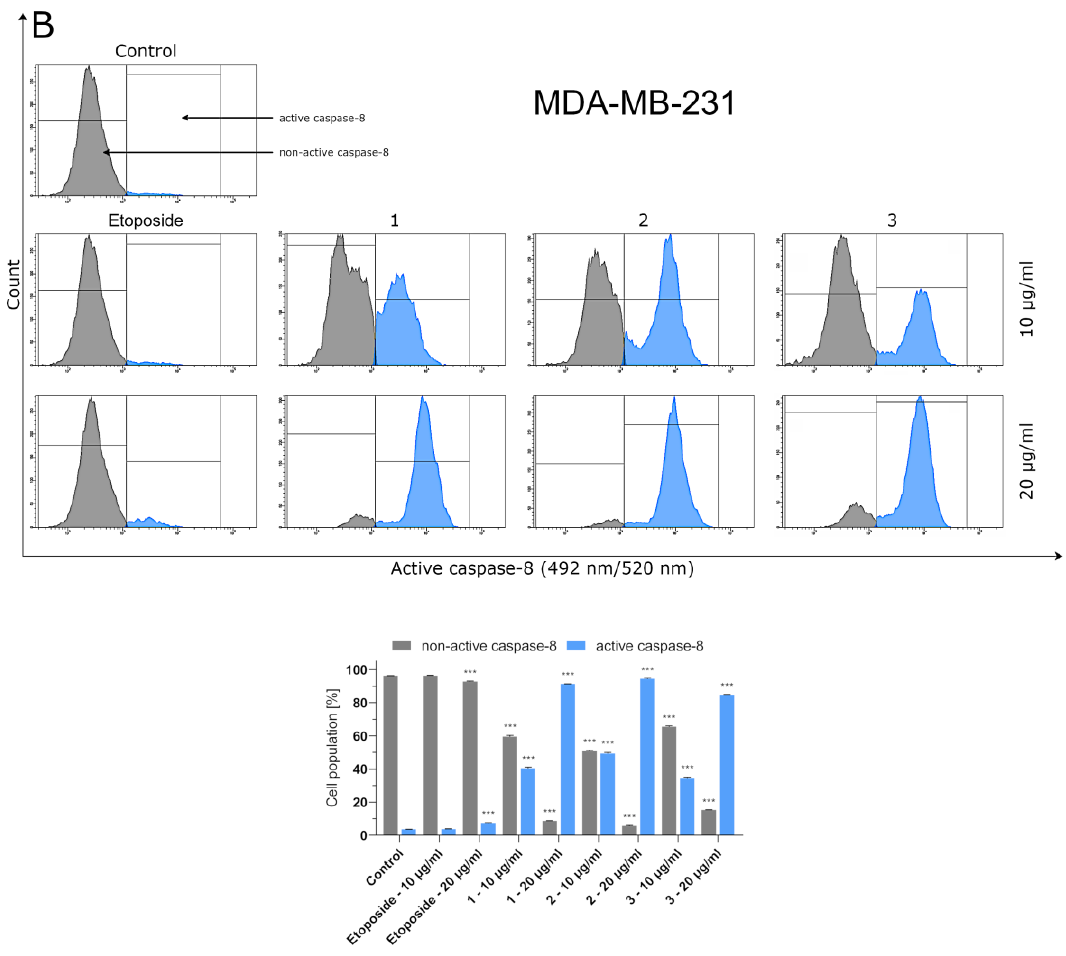
Figure 3. Flow cytometric analyses of MCF-7 ( A ) and MDA-MB-231 ( B ) breast cancer cells treated for 24 h with 1 – 3 and etoposide for active caspase-8. The compounds were tested at the following concentrations: 1 (10 µg/mL/23.83 µM and 20 µg/mL/47.66 µM), 2 (10 µg/mL/22.75 µM and 20 µg/mL/45.50 µM), 3 (10 µg/mL/23.78 µM and 20 µg/mL/47.56 µM) andetoposide (10 µg/mL/17 µM and 20 µg/mL/34 µM). Mean percentage values from three independent experiments (n=3) performedin duplicate are presented. ** p < 0.001 vs. control group.